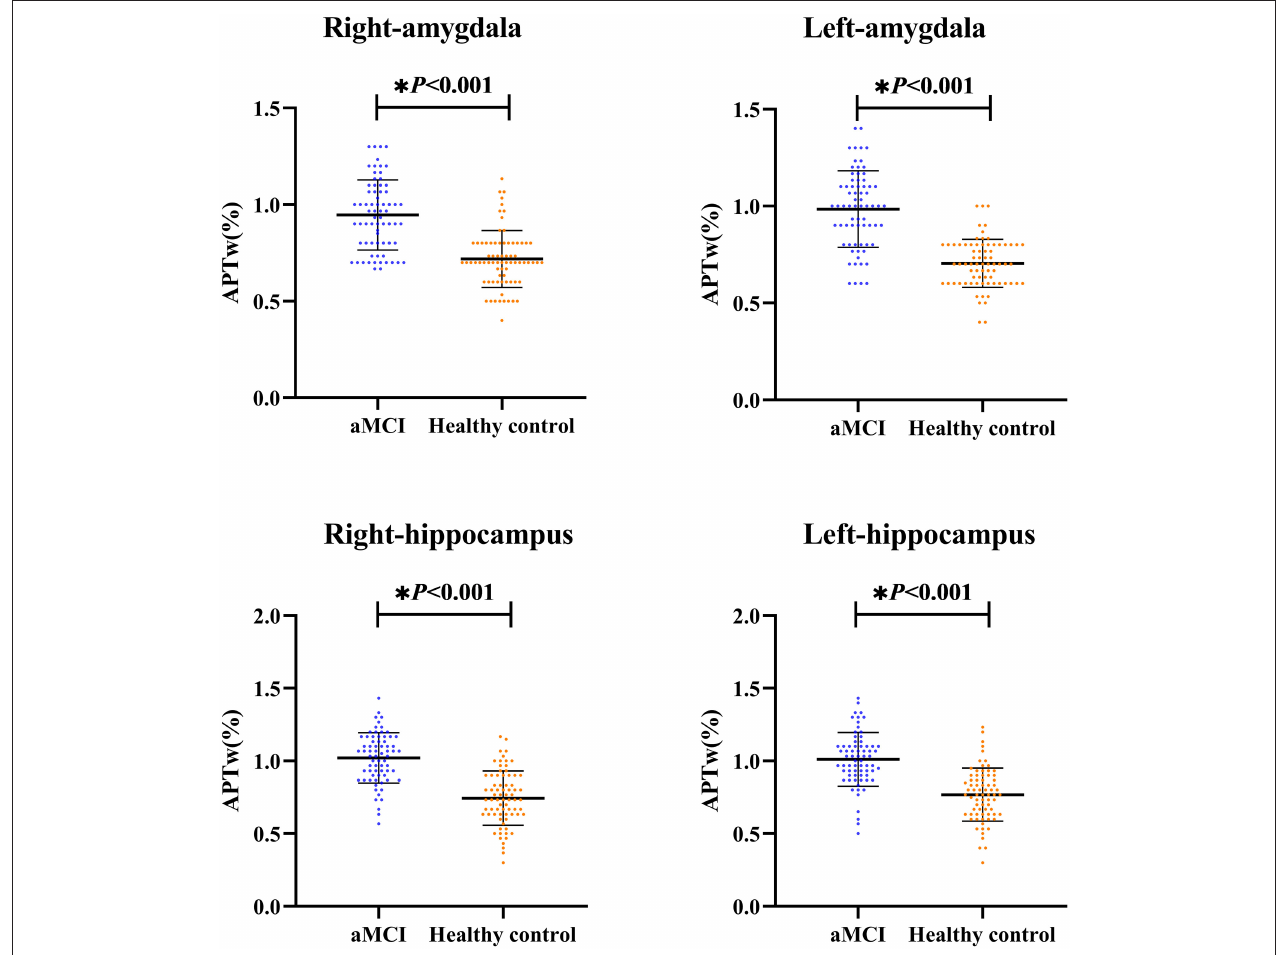
FIGURE 2 | The independent sample t -test for the APTw values. The results are shown from the regions of interest (ROIs) in aMCI groups (blue) and the healthy control (orange). * The difference was significant.